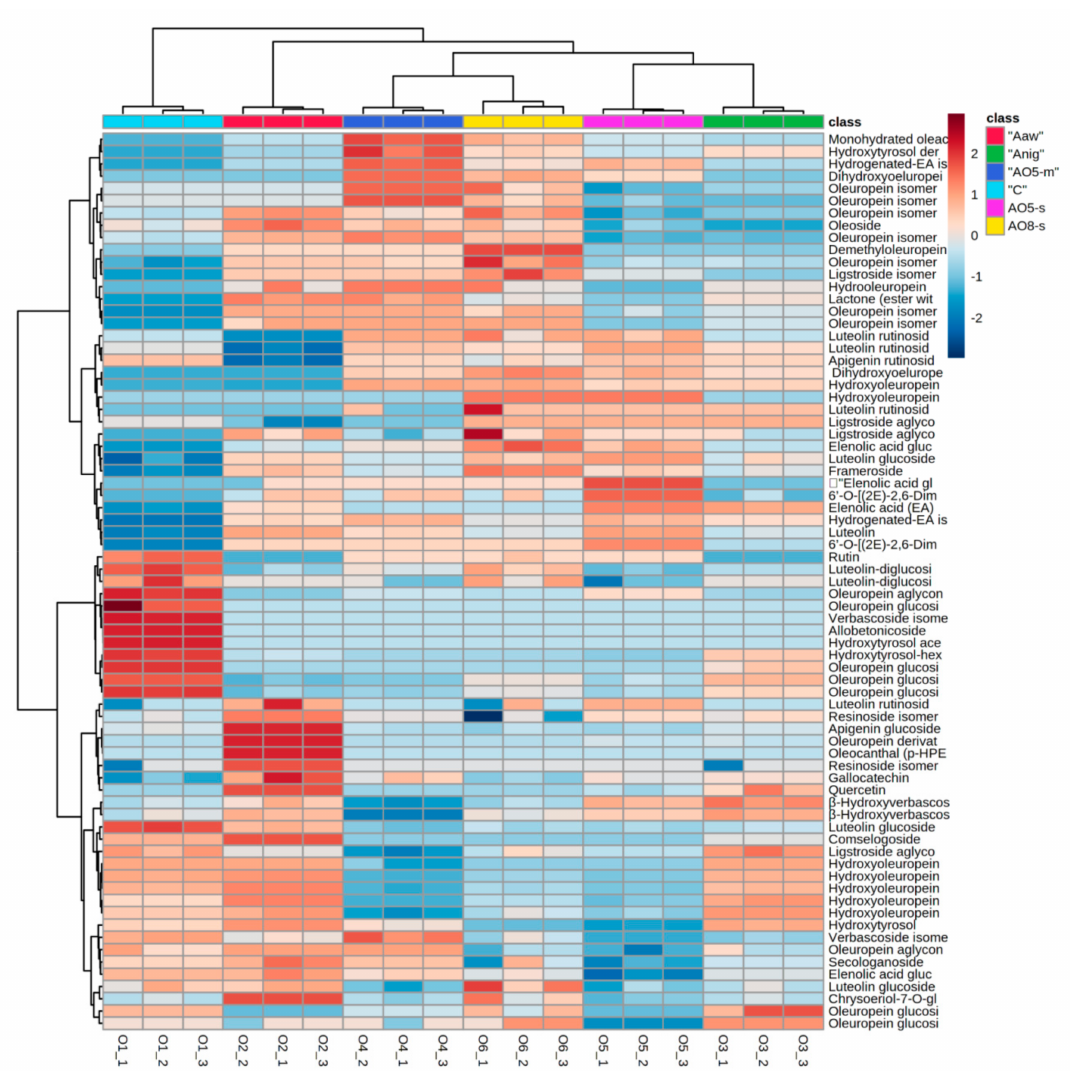
Figure 2. Hierarchical clustering analysis of phenolic compounds across the samples showing the distribution of target phenolic compounds and their